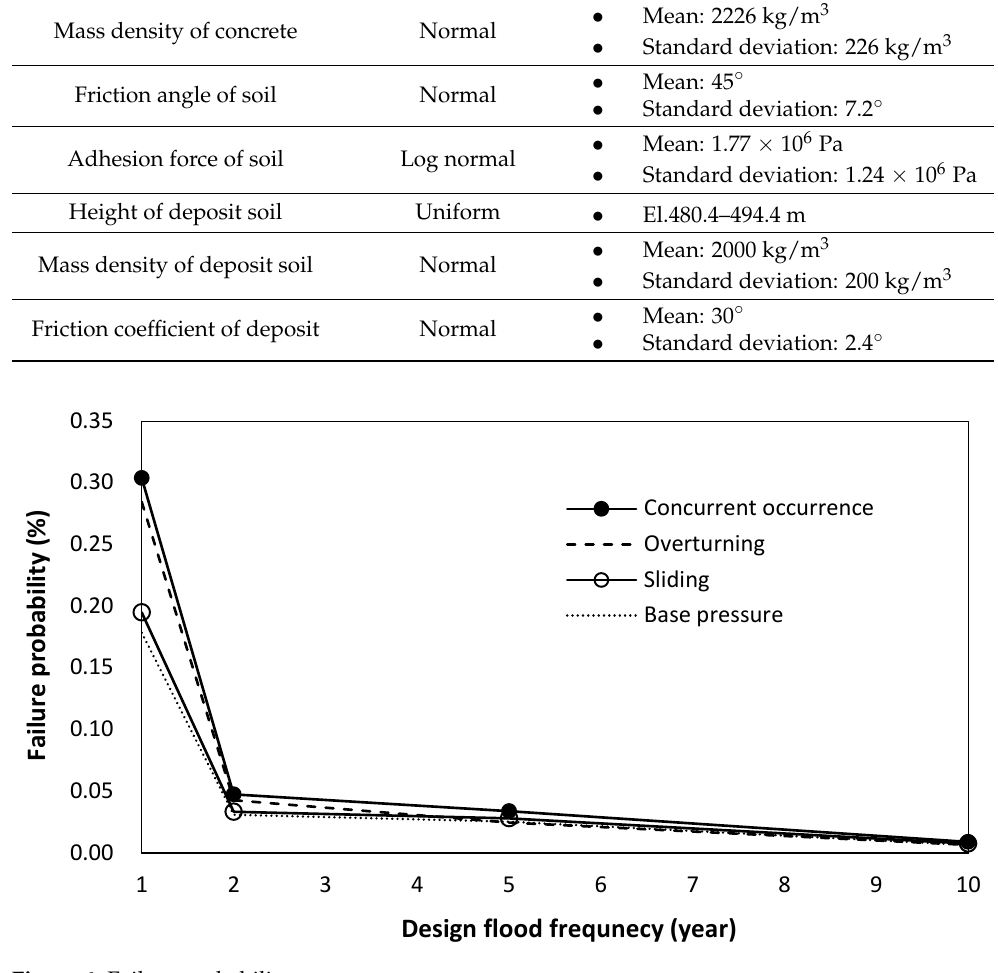
Figure 6. Failure probability.